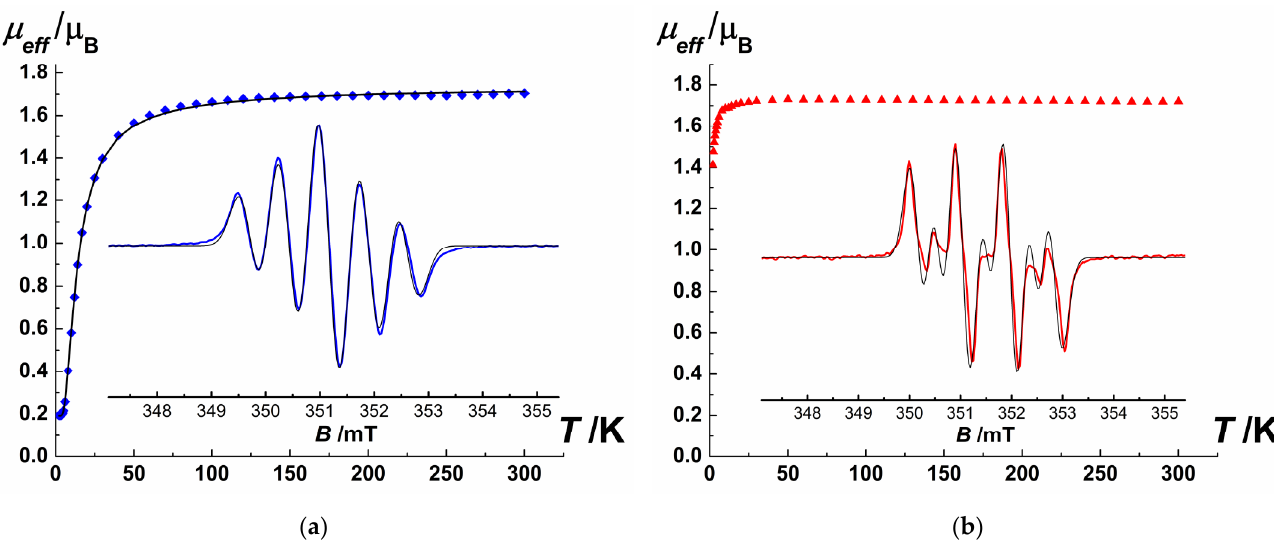
Figure 2. Experimental dependences µ eff (T) for the nitronyl nitroxide NNMn ( a —blue squares; solid thick black line — fitted data based on optimized parameters, Table S4) and imino nitroxide INMn ( b —red triangles). Insets: experimental EPR spectra for NNMn ( a —blue curve) and INMn ( b —red curve) recorded at room temperature in a degassed and diluted toluene solution; solid thin black curves—their modeling (Table S5).